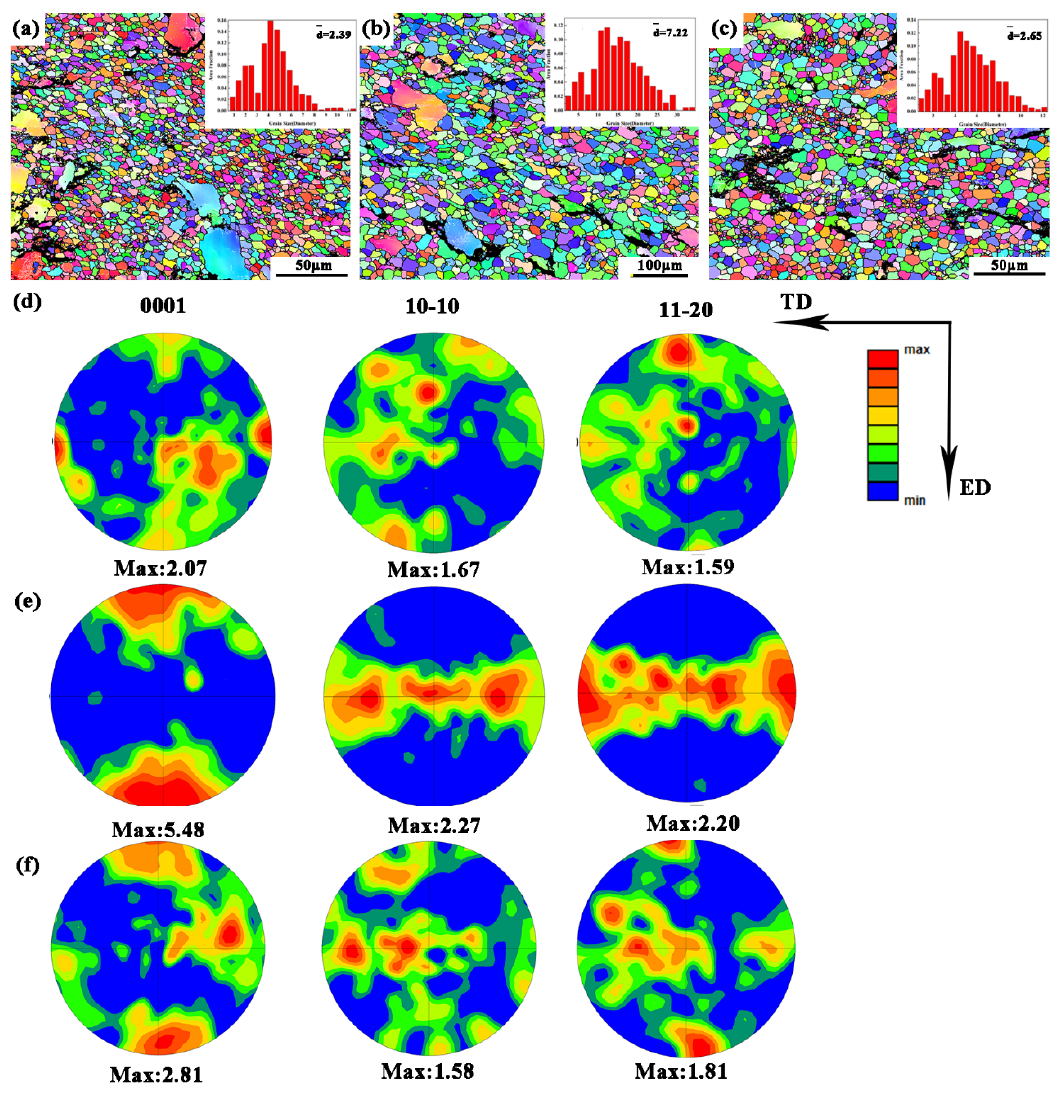
Figure 12. EBSD analysis and average grain size of DRX grains of the compressed Mg-13Gd-4Y-2Zn-0.4Zr (wt. %) samples parallel to ED direction: ( a ) L-653 sample; ( b ) L-743 sample; ( c ) H-743 sample (HAGBs, 15 ° < misorientation < 100 ° ) and low angle grain boundaries (LAGBs, 2 ° < misorientation < 15 ° ) are marked by black and white lines, respectively. Pole figure (PF) analysis of DRX grains of the compressed Mg-13Gd-4Y-2Zn-0.4Zr (wt. %) samples: ( d ) L-653 sample; ( e ) L-743 sample; ( f ) H-743 sample.